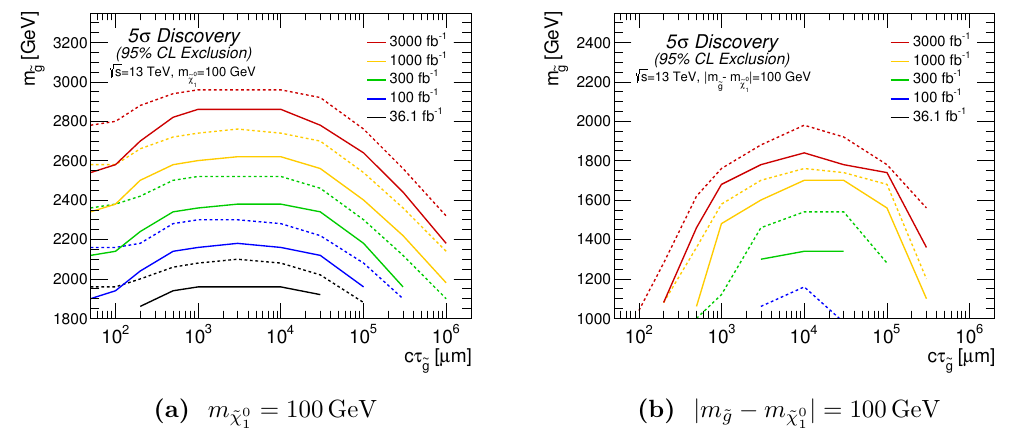
Figure 10. The expected 95% CL exclusion limits (dotted) and 5 (cid:27) discovery reaches (solid) as functions of c(cid:28) ~ g for di(cid:11)erent values of integrated luminosity at the 13 TeV LHC